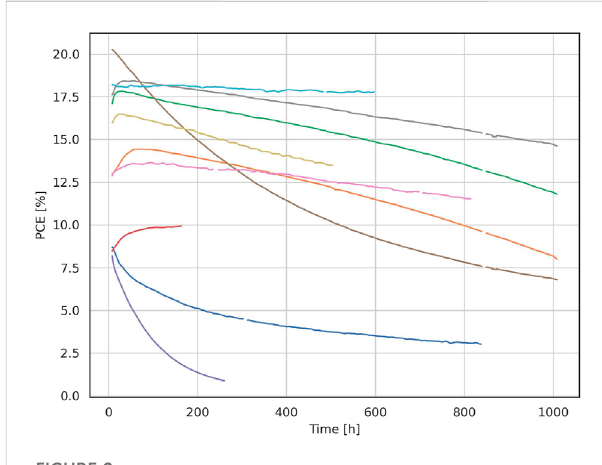
FIGURE 2 Exampleoftimeseriesdatafromthein-houseagingexperiments dataset. Each curve represents the aging of a different PSC (PCE evolution over time), showing the variety of behaviors in the aging of